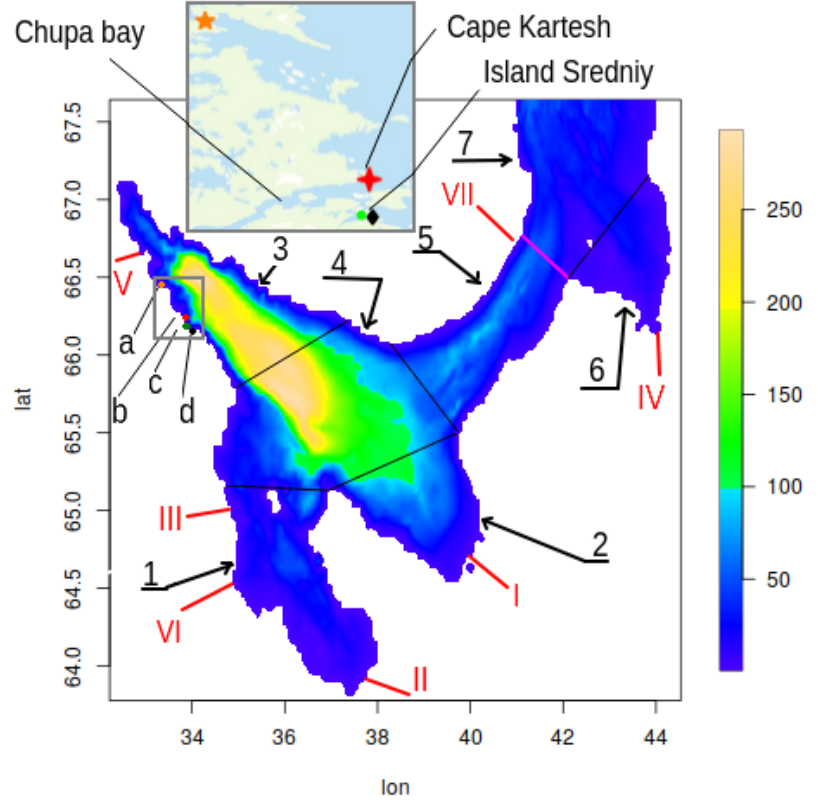
Figure 1. The White Sea bathymetry. The colour shows the depth in metres. Black lines are boundaries of the bays marked by arabic numbers: 1—Onega Bay, 2—Dvinskiy Bay, 3—Kandalakshskiy